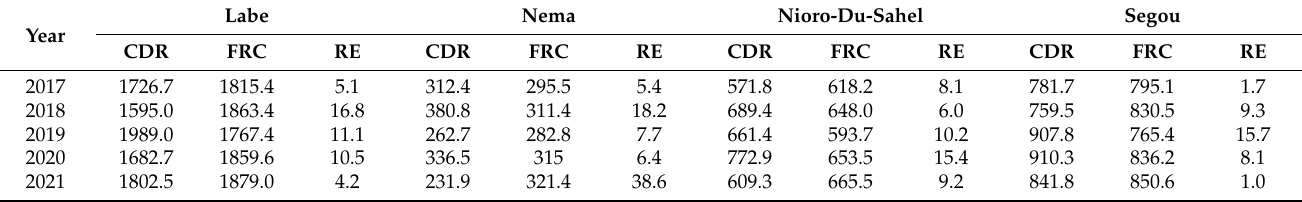
Table 4. Validation of the forecasted rainfall (FRC) in a 4-pixel sample with the “observed” rainfall PERSIANN-CDR (CDR) at the point-to-pixel from the last 5 years.